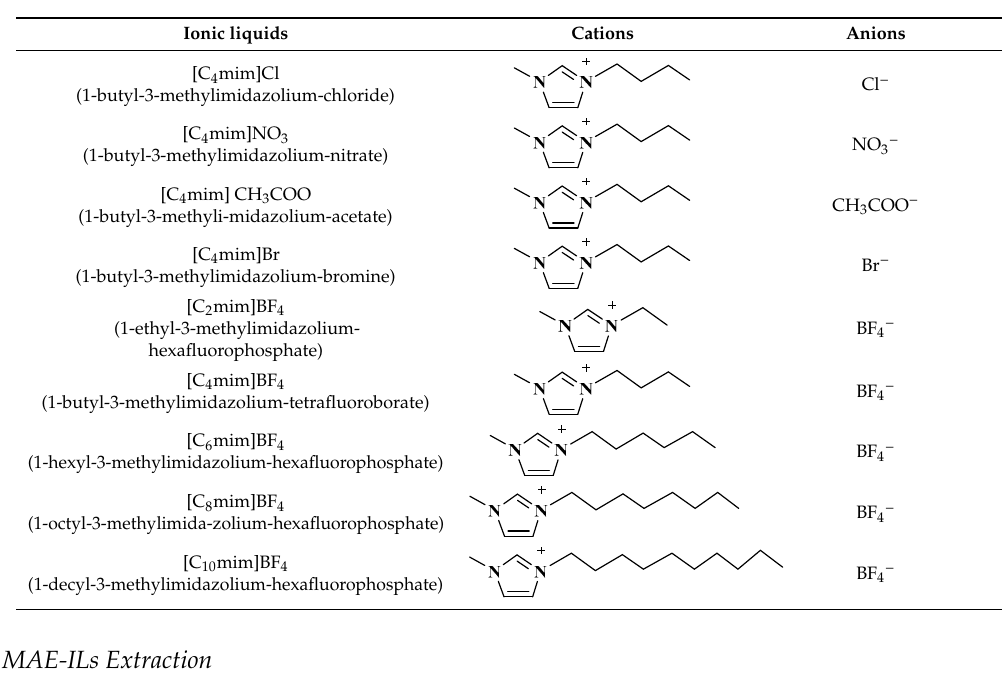
Table 5. Chemical structures of ionic liquids.